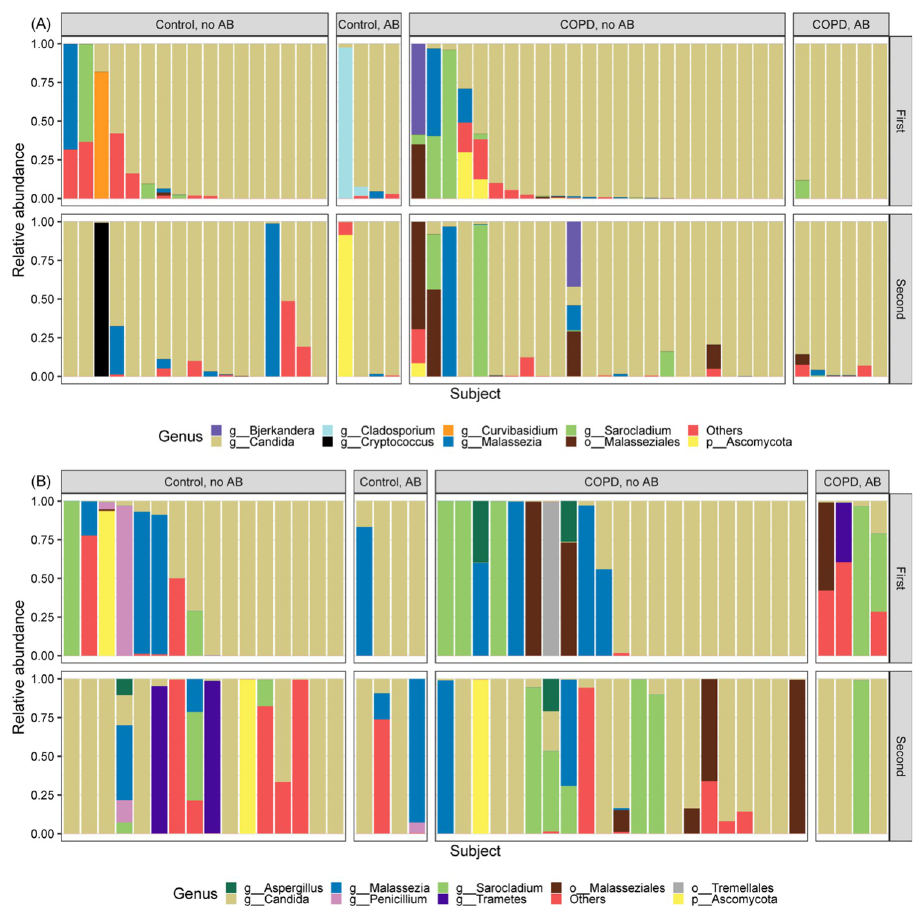
Fig 2. Most abundant fungal taxonomic assignments in (A) oral wash (51 participants) and (B) bronchoalveolar lavage (45 participants). AB: Intercurrent antibiotic use, First: first bronchoscopy, Second: second bronchoscopy. Taxa are sorted on Candida in the first bronchoscopy. Each column represents a sample, and columns from the first bronchoscopy and the second bronchoscopy correspond to each other. That means, a first bronchoscopy column above and the corresponding second bronchoscopy column below show samples from the same participant. Not all sequences could be assigned taxonomy at the genus level and are therefore displayed as o__Malasseziales , o__Tremellales , or p__Ascomycota